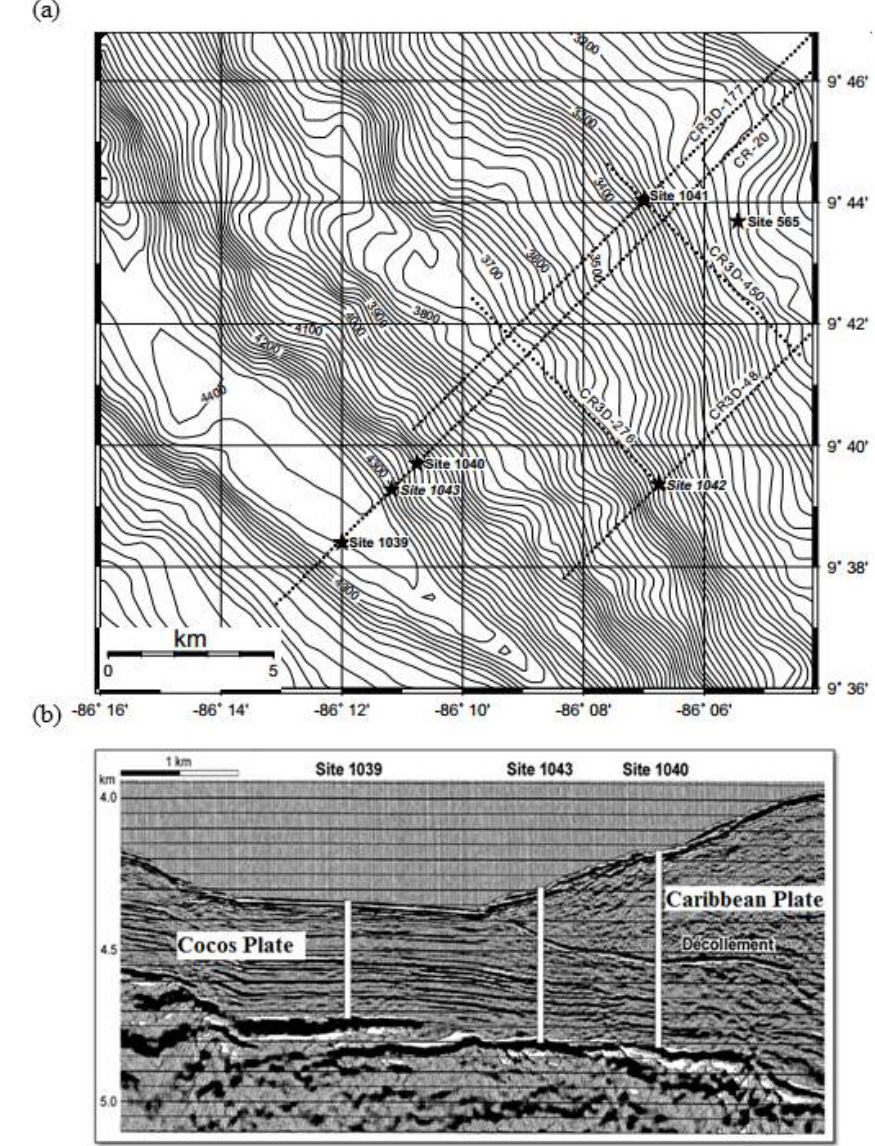
Figure 4. (a) Bathymetry map with an interval of 20m (b) , seismic depth section along with the well site of the study area (after Moritz et al.,